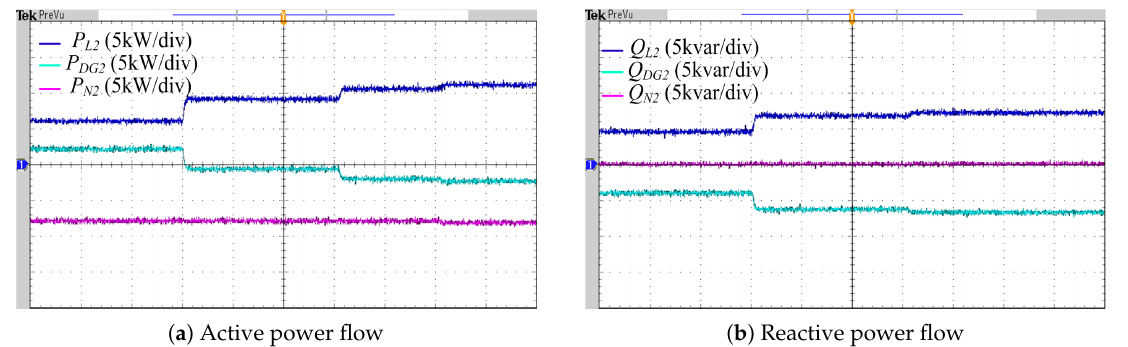
Figure 7. Power curves in